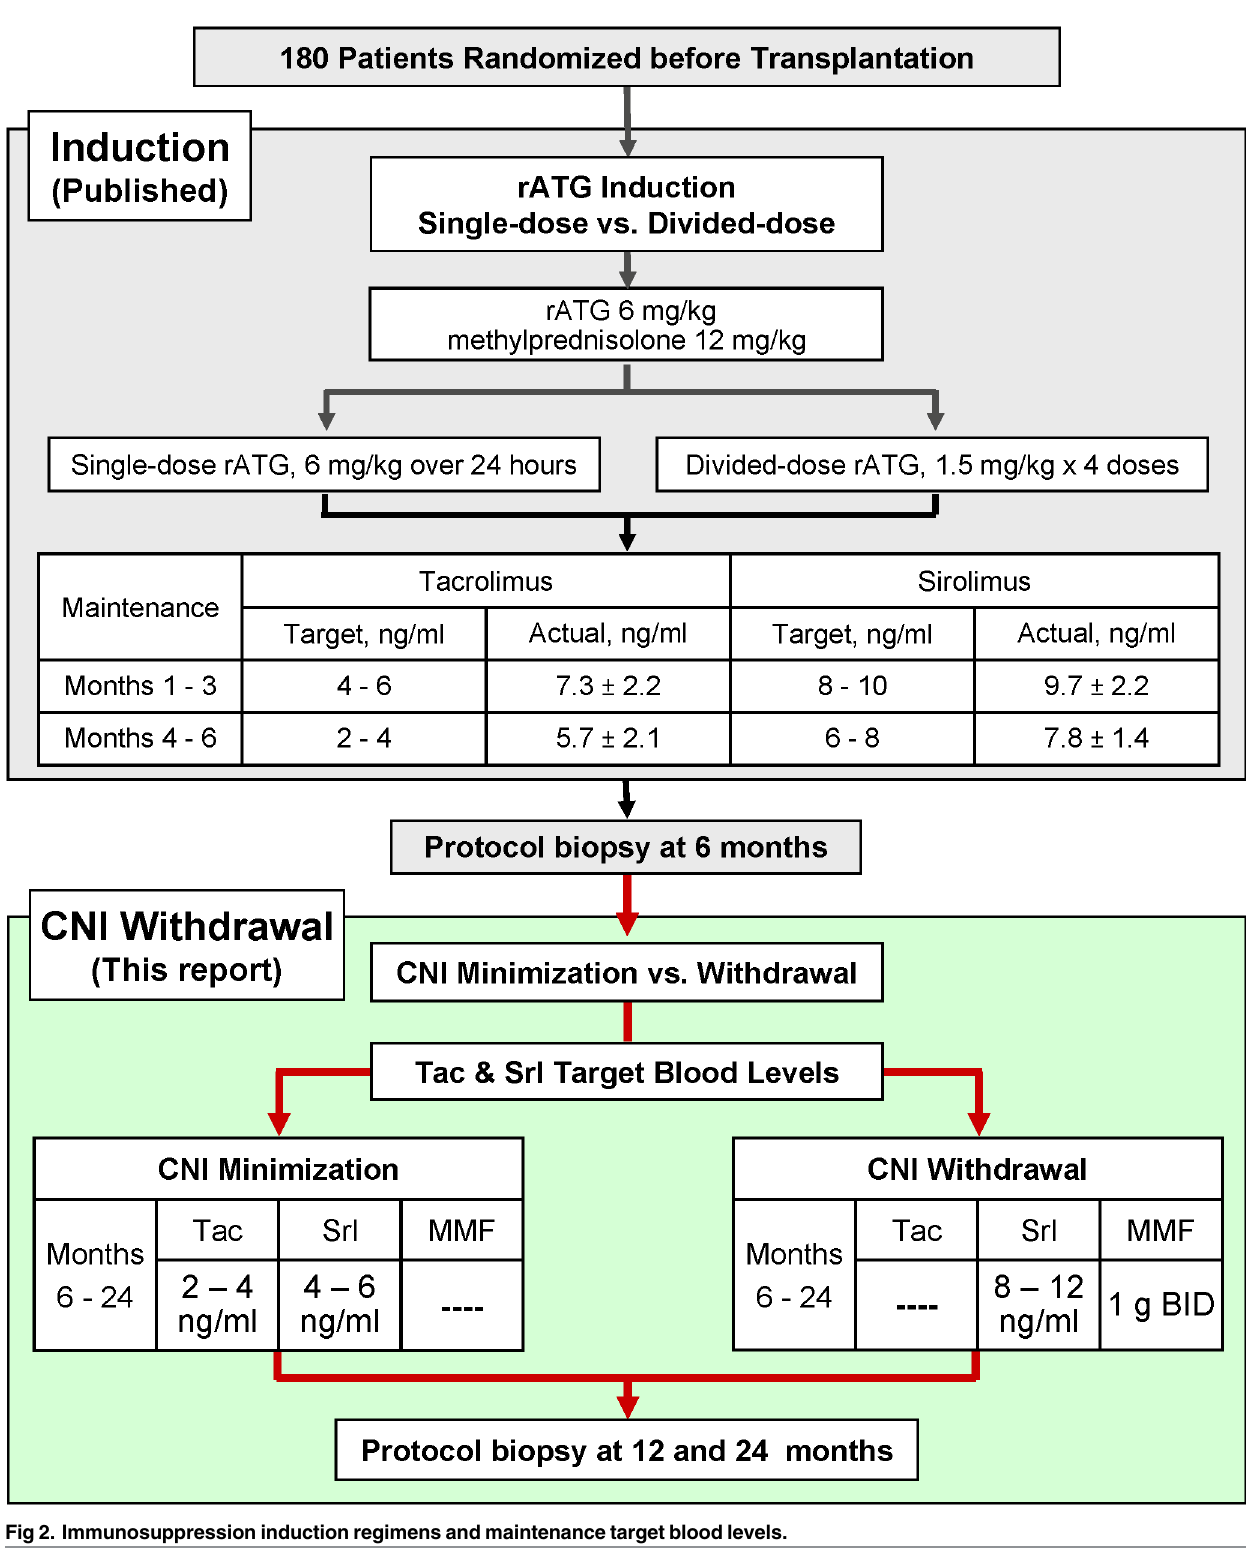
Fig 2. Immunosuppression induction regimens and maintenance target blood levels.